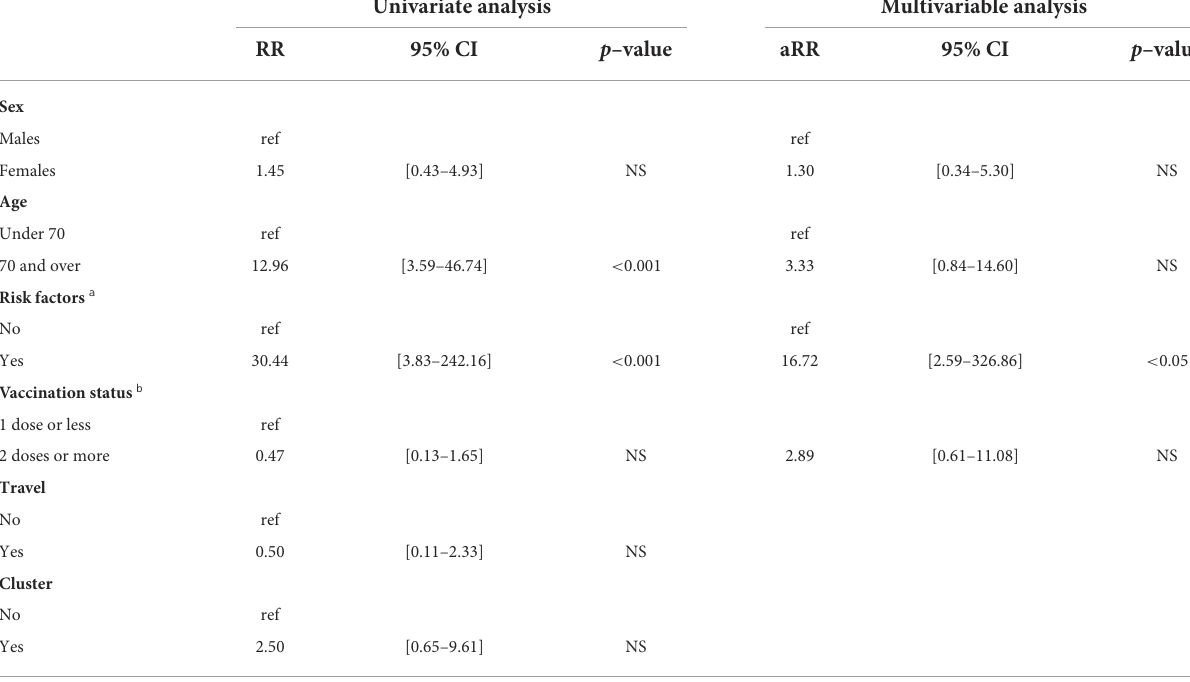
TABLE 2 Univariate and multivariate analysis for risk of hospitalization among BA.4 and BA.5 cases. Univariate analysis Multivariable